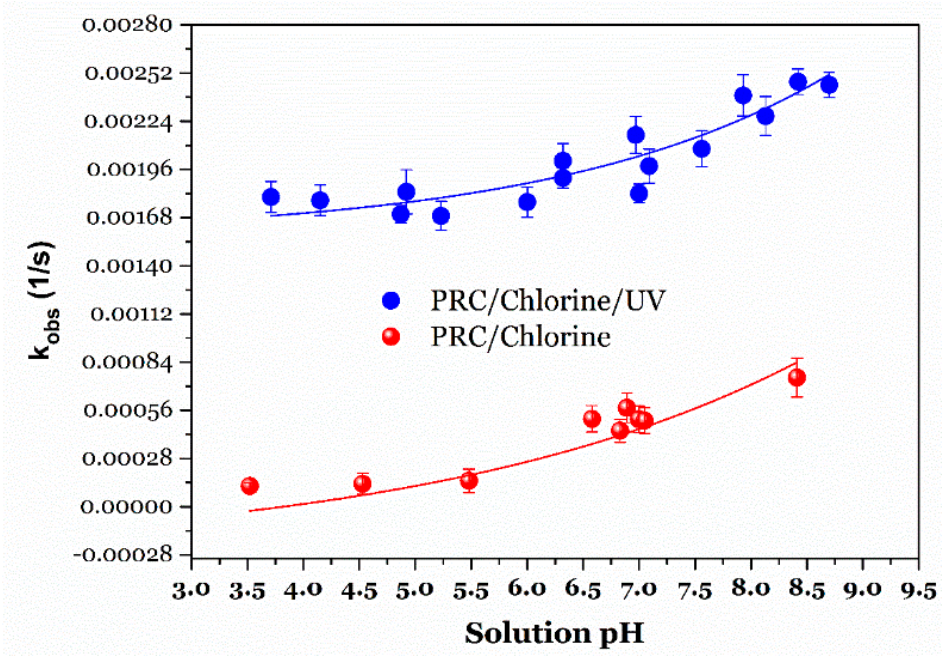
Figure 5. Effect of solution pH on PRC degradation rate constant by NaClO and NaClO/UV (Experimental conditions: UV photon flux = 3.41 × 10 − 6 Einstein/s, [PRC] o = 10 μ M, and [NaClO] o ≈ 100 μ M).